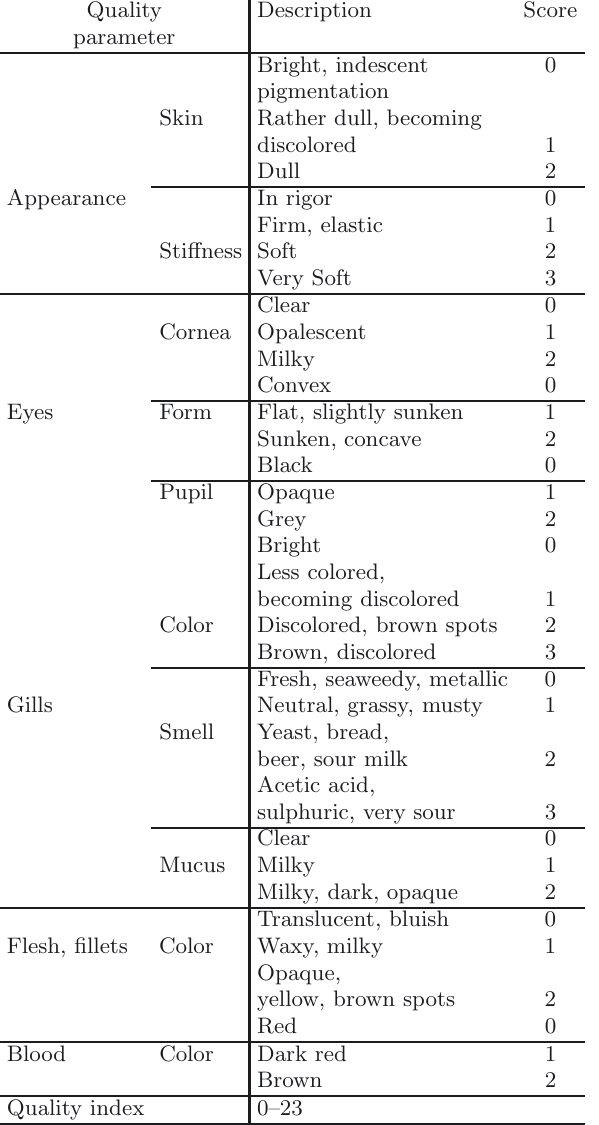
Table 3. An example of an indexed table (www.qim-eurofish.